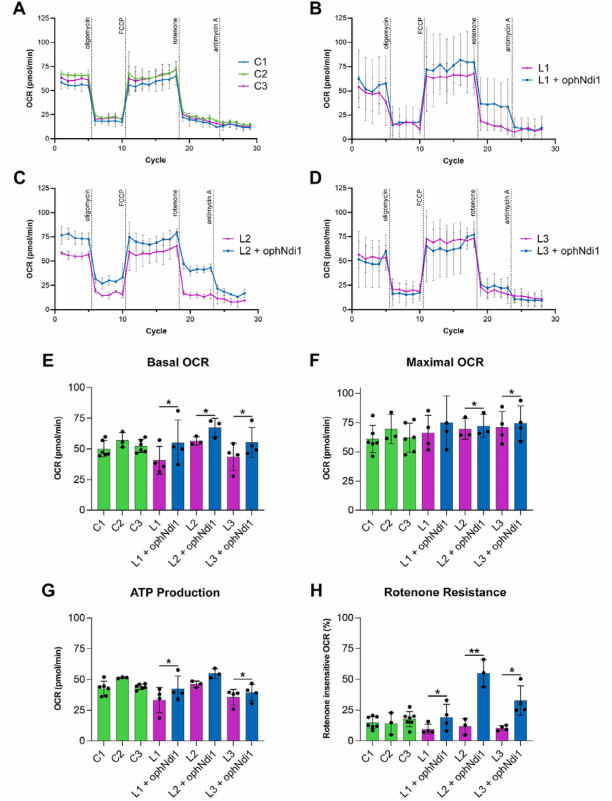
Figure 3. Bioenergetic analysis of AAV-ophNdi1 in LHON patient-derived fibroblasts. Fibroblasts transduced with AAV-ophNdi1 (blue bars) at an MOI of 3.4 × 10 5 were compared to untransduced patient fibroblasts (pink bars) and untreated unaffected age matched control fibroblasts (green bars), n = 5. At 48 h post-transduction a mitochondrial stress test was performed on a Seahorse XFe96 Analyser. Oligomycin (1.0 µ M), FCCP (2.25 µ M), rotenone (0.5 µ M) and antimycin A (0.5 µ M)